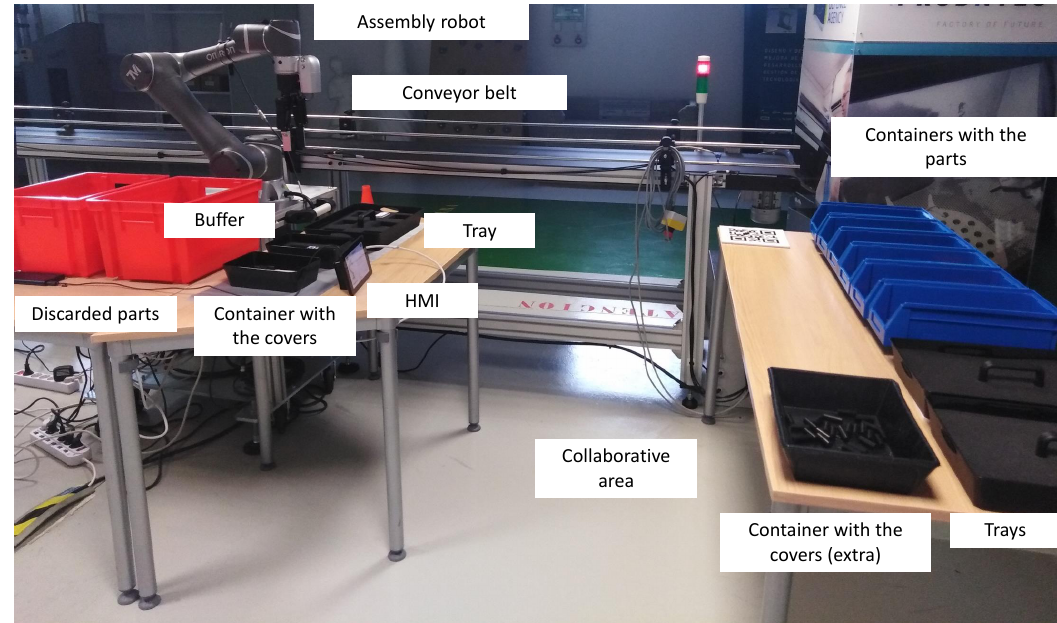
Figure 11. Detailed view of the collaborative area (real